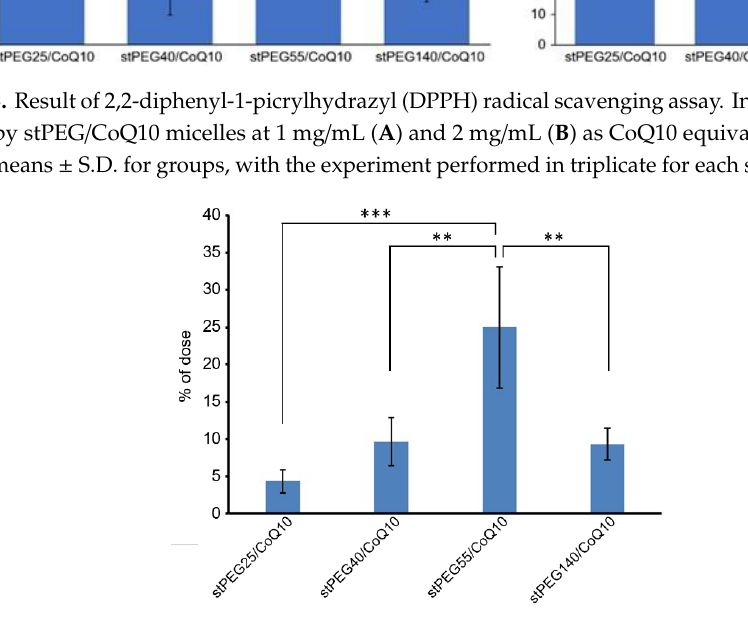
Figure 4. The CoQ10 levels in the plasma 1 h after a single injection of stPEG/CoQ10 micelles with 4 mg/kg in CoQ10 equivalents in mice. The values are the means ± S.D. for groups of four mice; ** p < 0.01, *** p < 0.001.